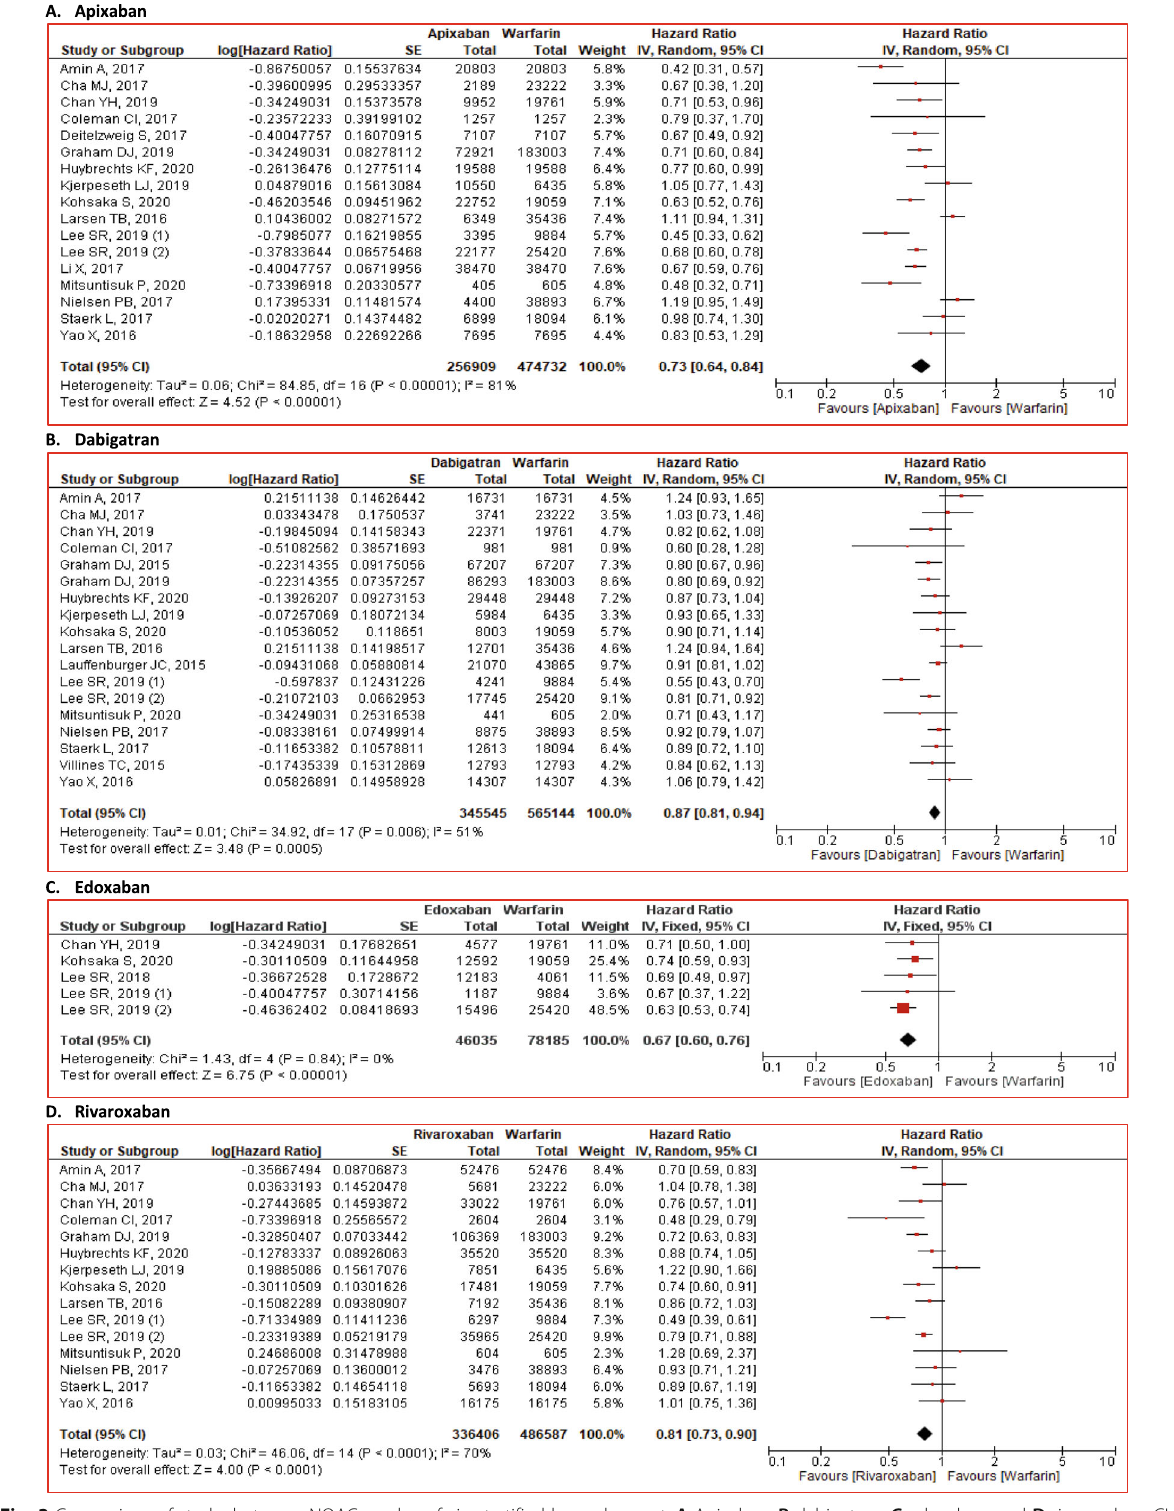
Fig. 3 Comparison of stroke between NOACs and warfarin stratified by each agent. A Apixaban, B dabigatran, C edoxaban, and D rivaroxaban. CI = confidence interval, NOACs = non-vitamin K antagonist oral